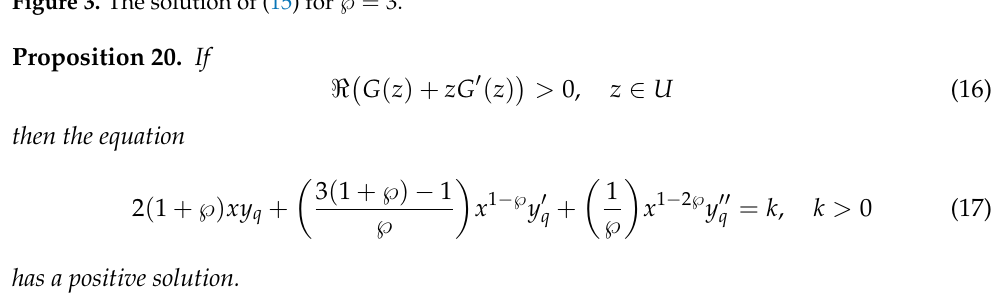
Figure 3. The solution of (15) for ℘ =